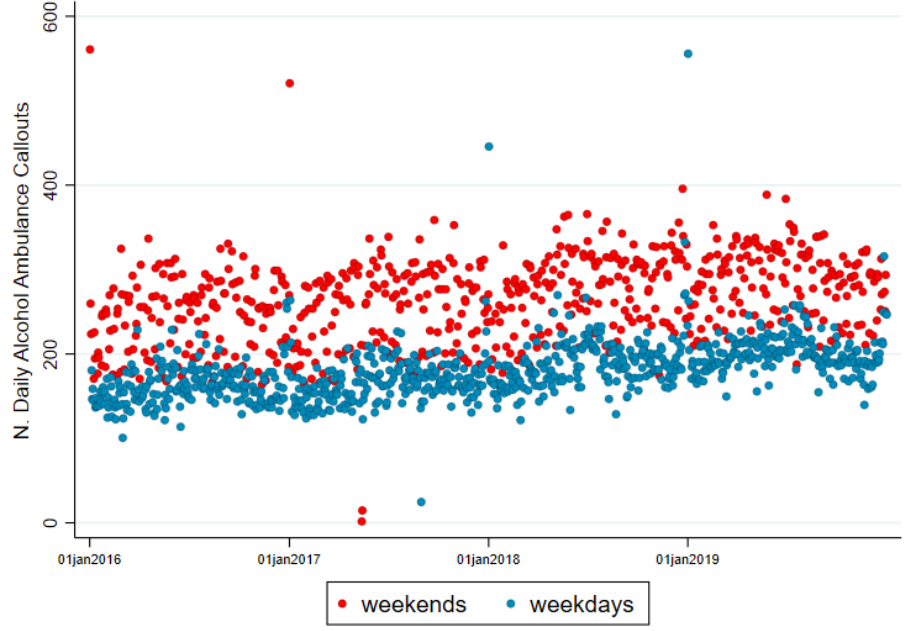
Figure 1. Daily alcohol – related ambulance callouts,